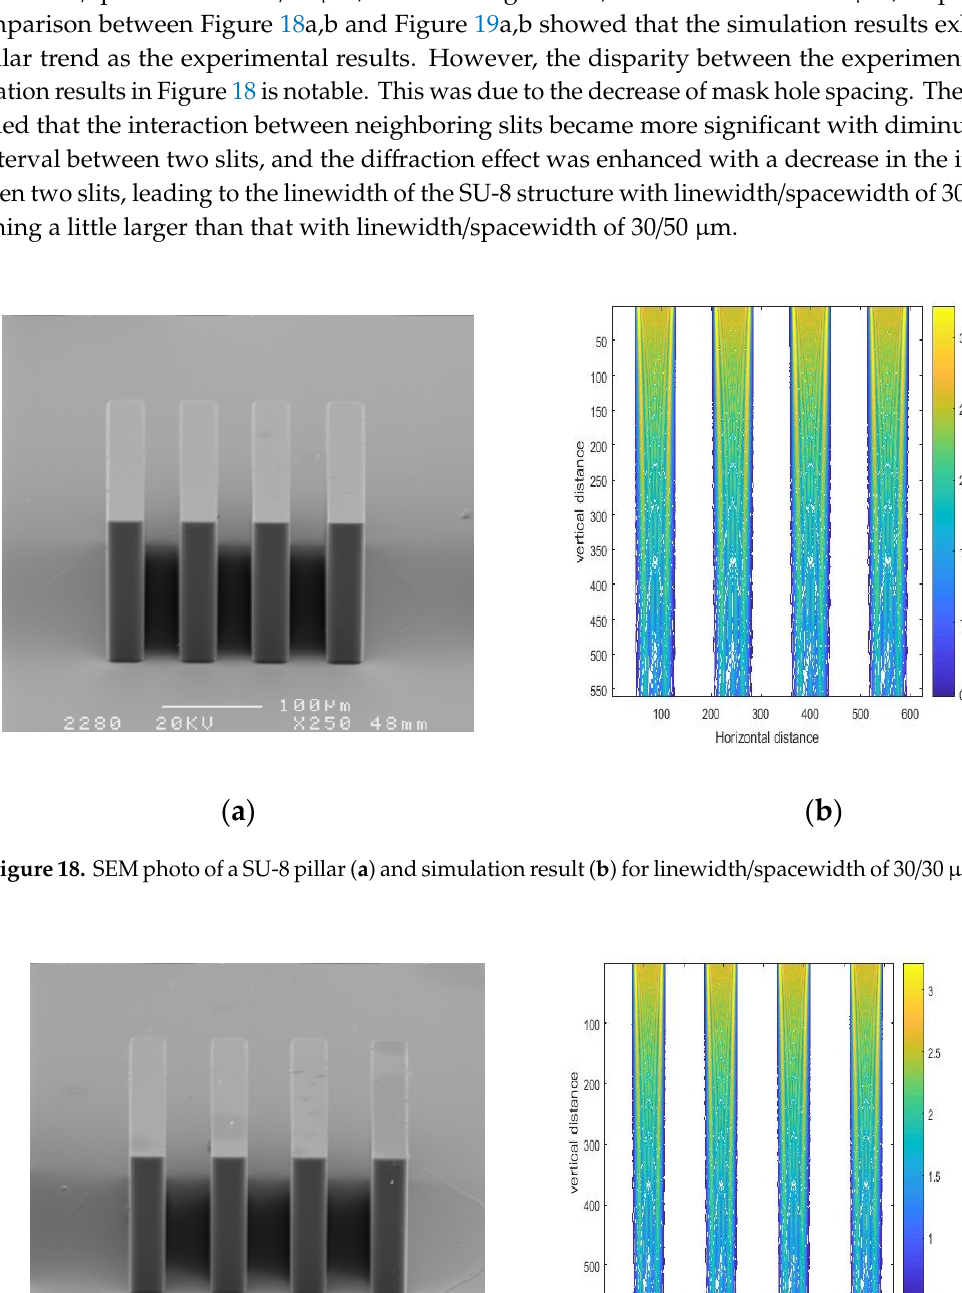
Figure 19. SEM photo of a SU-8 pillar ( a ) and simulation result ( b ) for linewidth/spacewidth of 30/50 μ m. SEM photos of the oblique SU-8 structures fabricated on glass wafers are illustrated in Figure 20a, and the corresponding simulation results are shown in Figure 20b. Figure 20a,b shows the intensity distribution of photoresist in the case of multiple mask holes with the incident angle of 30 linewidth / spacewidth of 30 / 60 µ m. From Figure 20a, we can see that the width of the top SU-8 was 31.75 µ m, and the width of the bottom SU-8 was 33.40 µ m. Therefore, the top and bottom widths